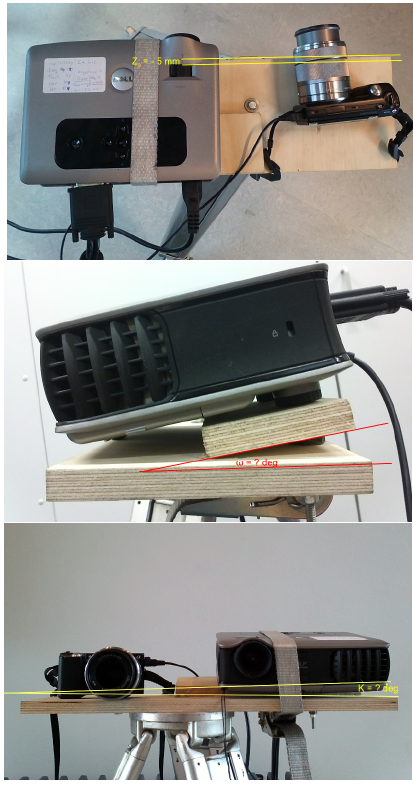
Figure 3: Prototype camera-projector